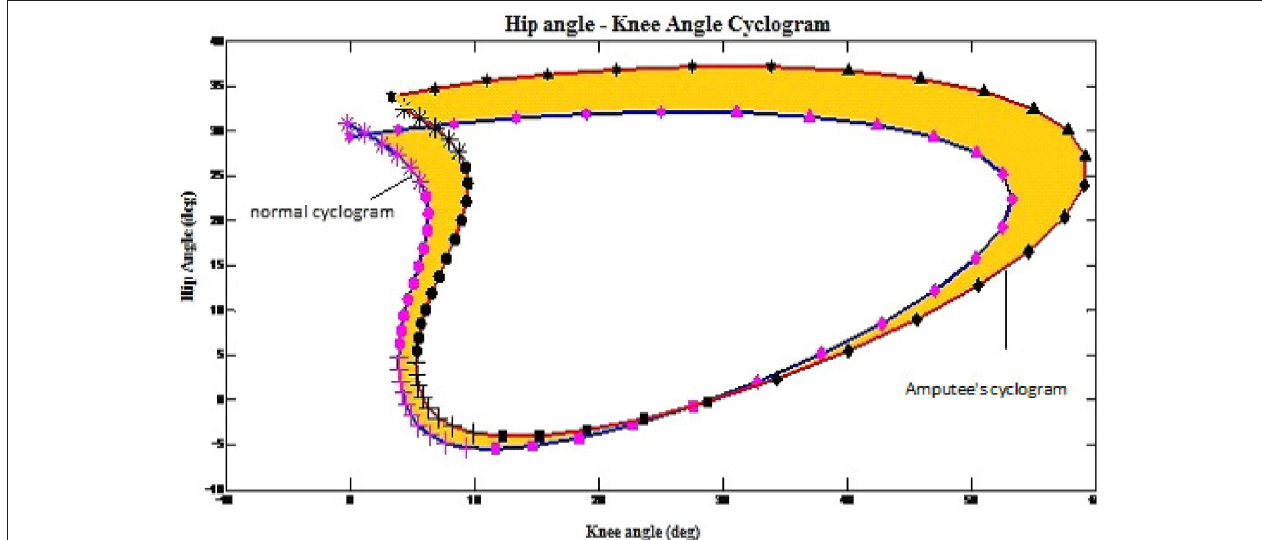
FIGURE 1 | Example on how the cyclograms being applied to obtain the gait disparity in amputees. The shaded area indicate disparity from norm.